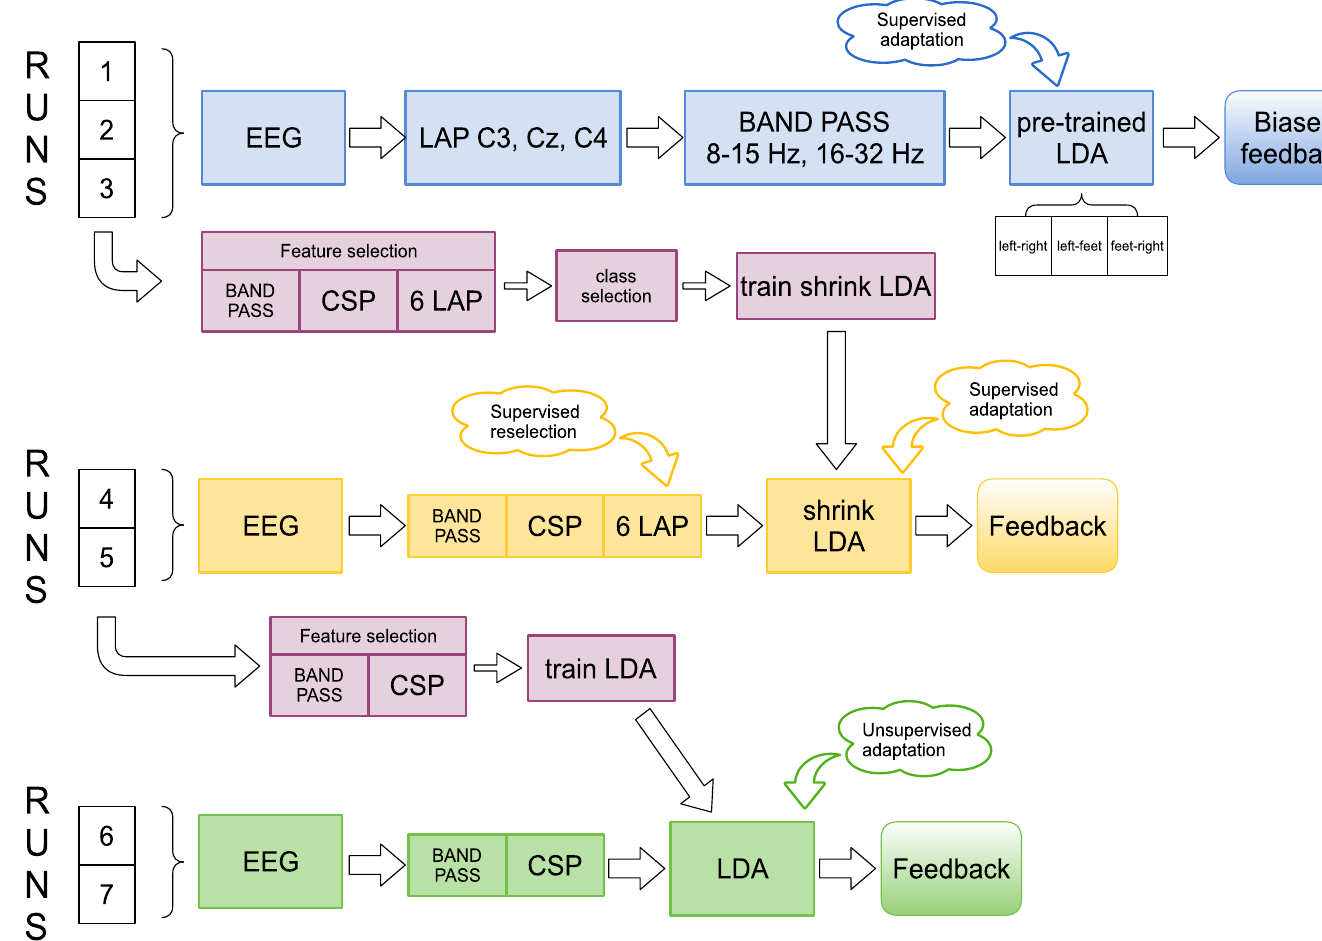
Fig 1. Schematic flowchart of the online protocol. The EEG processing and adaptation protocol during runs 1 – 3 with positive biased feedback are depicted in blue, in yellow the processing and adaptation during runs 4 – 5 with real feedback, in green the processing and adaptation during runs 6 – 7 also with real feedback. The adaptation applied in runs 1 – 3 and 4 – 5 uses supervised methods, the adaptation of runs 6 – 7 uses unsupervised methods. In magenta are depicted the phases of subject-specific features selection (e.g. frequency band, CSP filters, etc) and training of the classifier that happened two times, i.e. after runs 1 – 3 and after runs 4 –